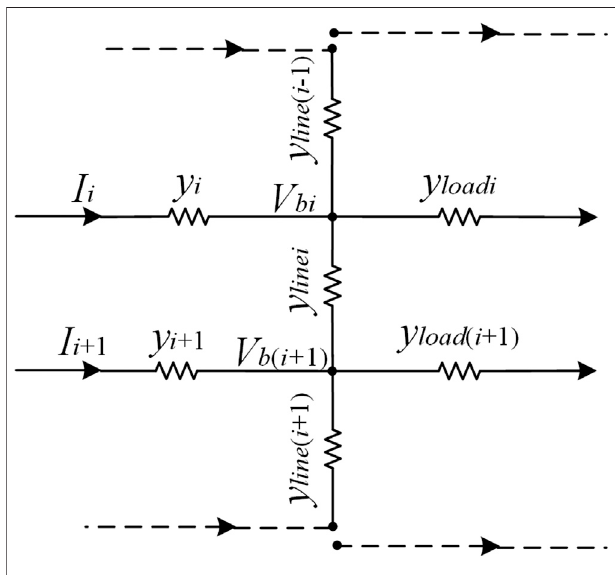
FIGURE 2 | Network con fi